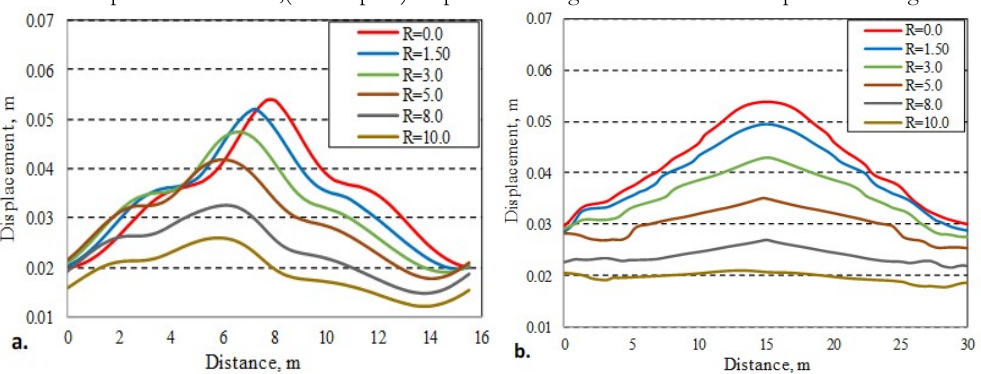
Figure 19: a. Maximum pressure at Path 1,(critical path).b. pressure along Path 1 at 0.03 sec. c. pressure along Path 2 at 0.03 sec.